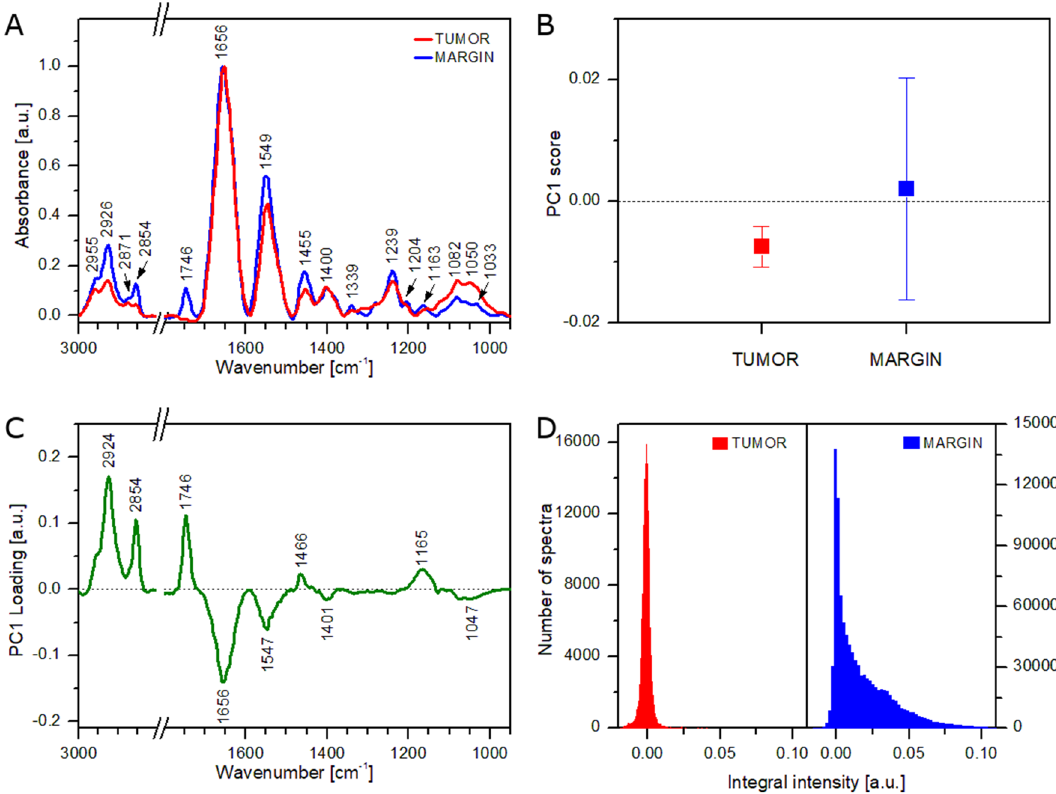
Figure 3. Results of FT-IR analysis of tumoral tissue and healthy margin using all acquired spectra: average FT-IR spectra ( A ), mean values of PC1 score ( B ), PC1 loading plot ( C ), histograms showing the distribution of integral intensity of the 1746 cm −1 band ( D